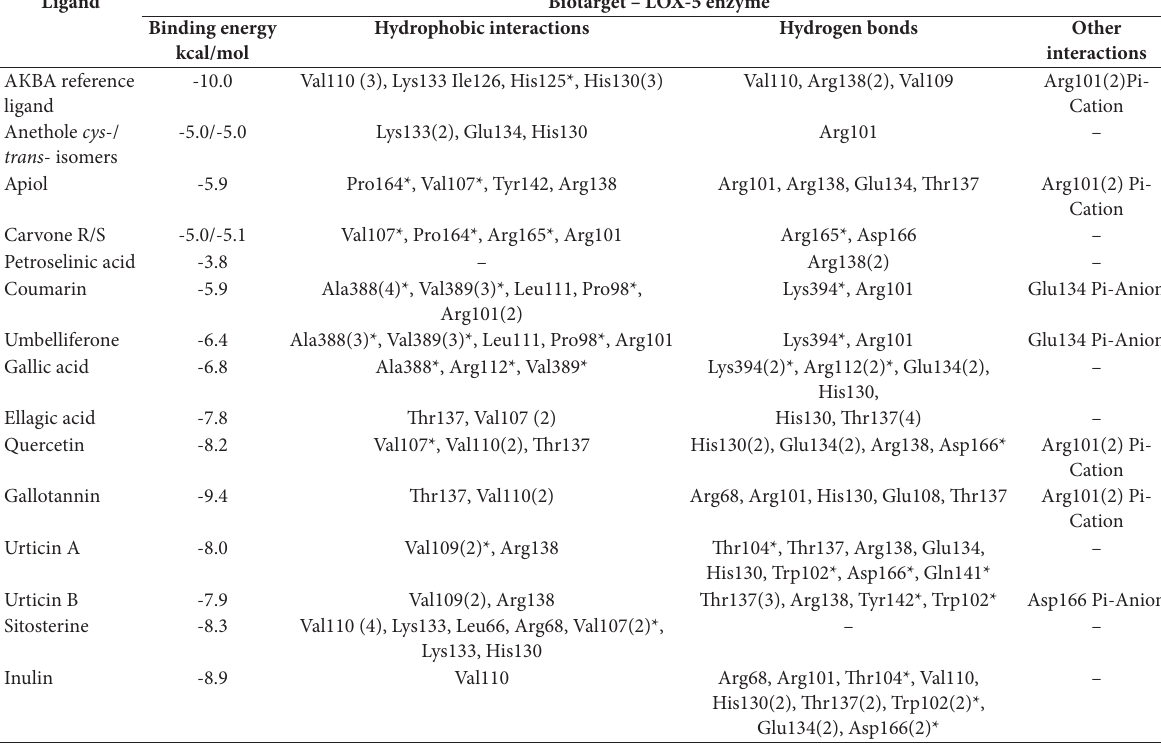
Table 1. Docking results of the studied substances into the LOX-5 active site